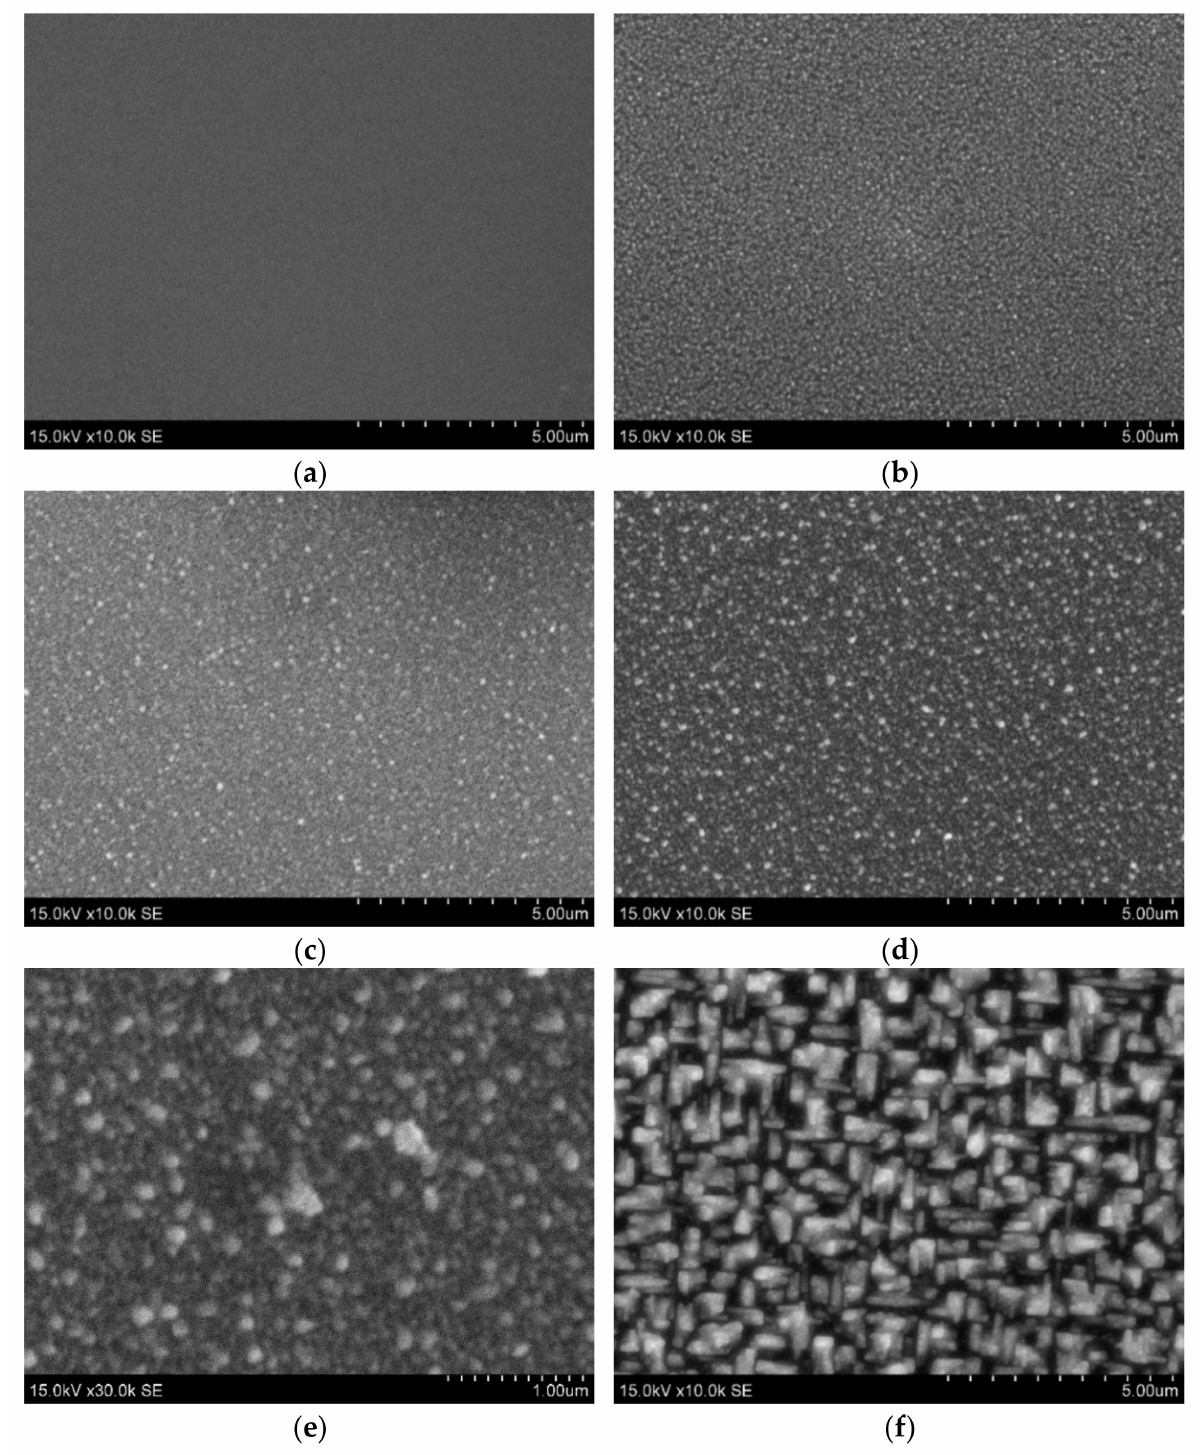
Figure 2. Surface morphology of the ( a ) MS1, ( b ) MS2, ( c ) MS3, ( d , e ) MS4, and ( f ) MS5 films obtained using magnetron